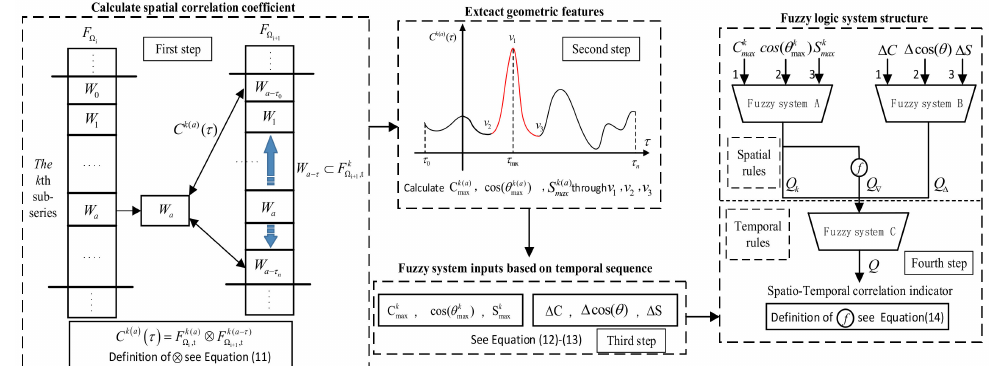
Figure 5. Stepwise structure of anomaly identification